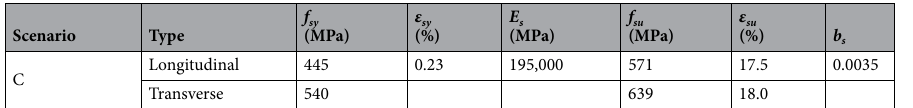
Table 1. Experimental mechanical properties of longitudinal and transverse reinforcement. f sy : yield strength of steel.